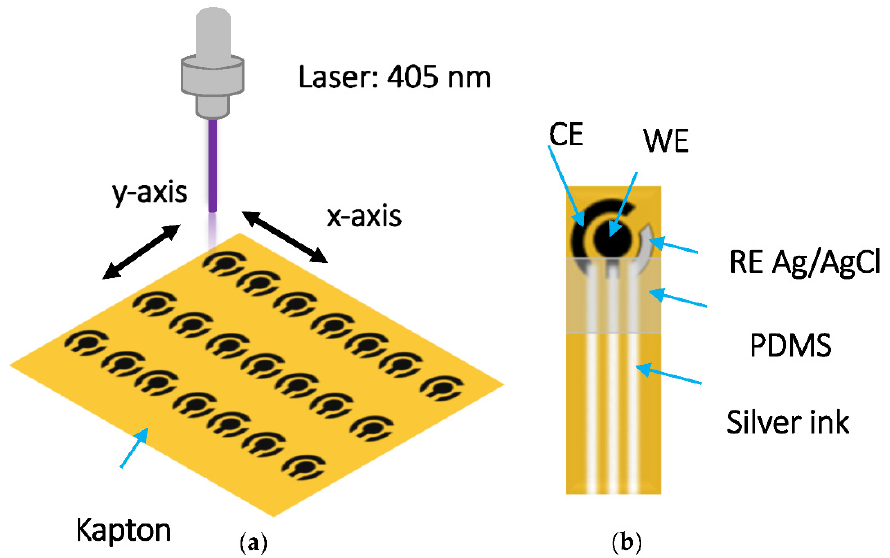
Figure 1. Schematic representation of ( a ) patterned electrodes and ( b ) prepared sensor.